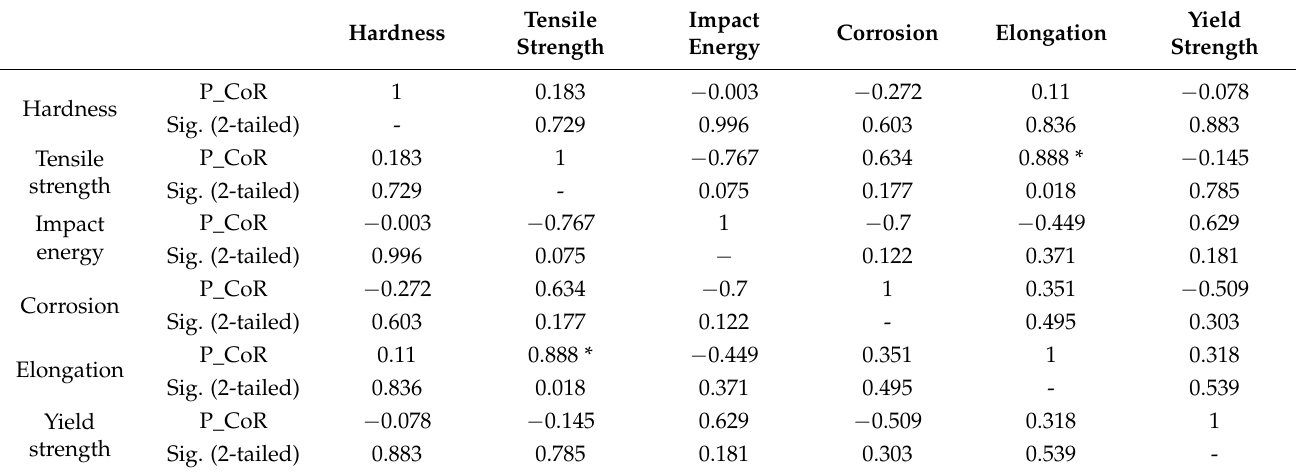
Table A1. Correlations between mechanical properties of FSW butt joint.